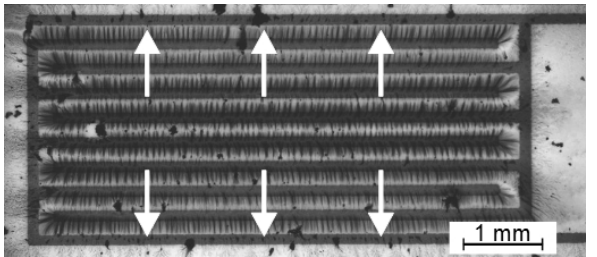
Figure 8. Light optical microscope image of a soot loaded interdigital electrode structure. The soot accumulates in form of percolation paths, growing from one electrode to the other. Exhaust gas hit the sensor perpendicular to the surface and spread as indicated by the arrows.